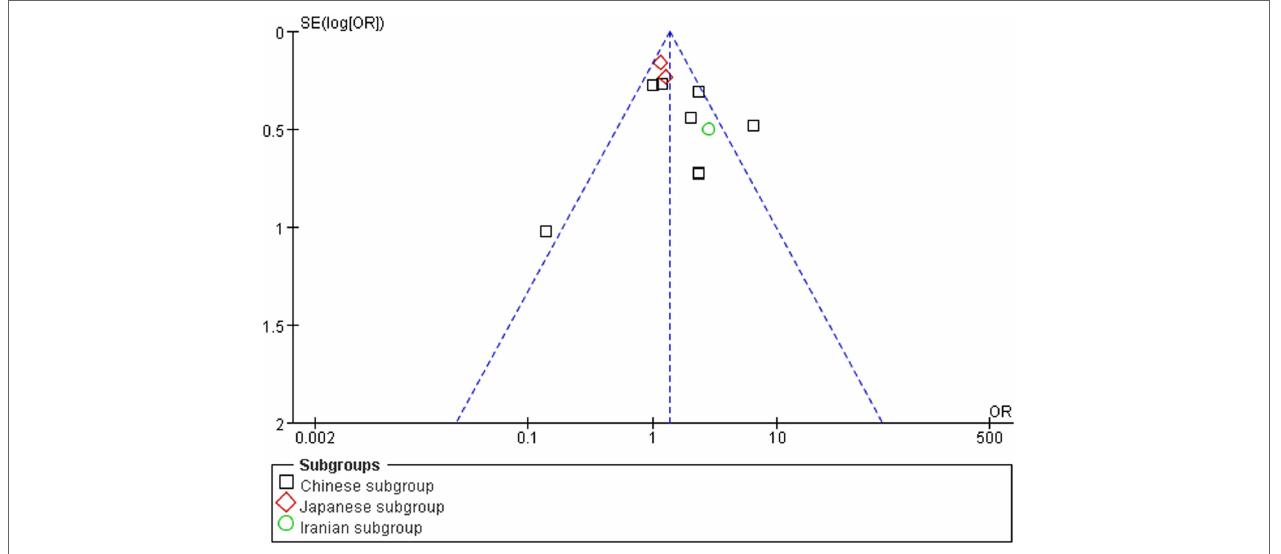
FigUre 7 | Funnel plot for studies of the association of type 2 diabetes mellitus and small ubiquitin-like modifier 4 gene M55V polymorphism under a recessive genetic model (VV vs. MM + MV). The horizontal and vertical axis correspond to the OR and confidence limits. OR, odds